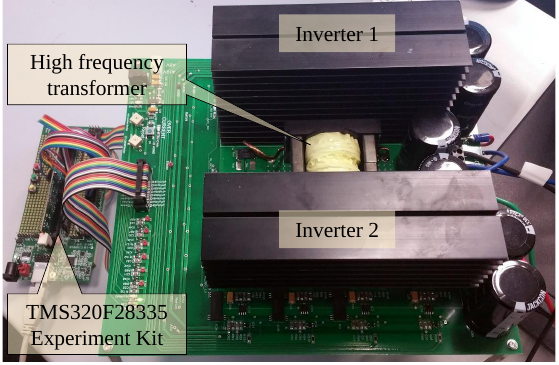
Figure 9. Laboratory-scaled experiment